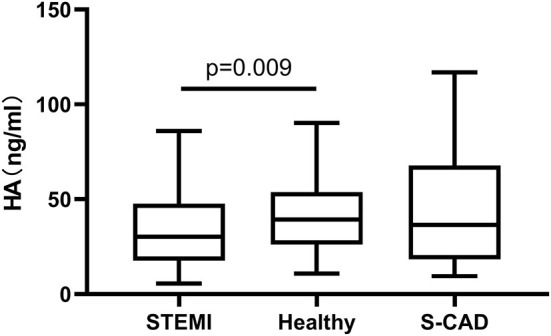
Relations of plasma HA levels among patients with STEMI, S-CAD and healthy subjects. HA, hyaluronan; STEMI, ST-Segment–Elevation Myocardial Infarction; S-CAD, Stable Coronary Artery Disease.